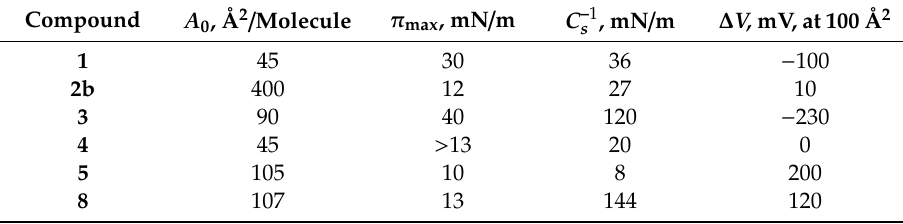
Table 3. Characteristics of Langmuir isotherms of thiacalixarene chromophores (limiting